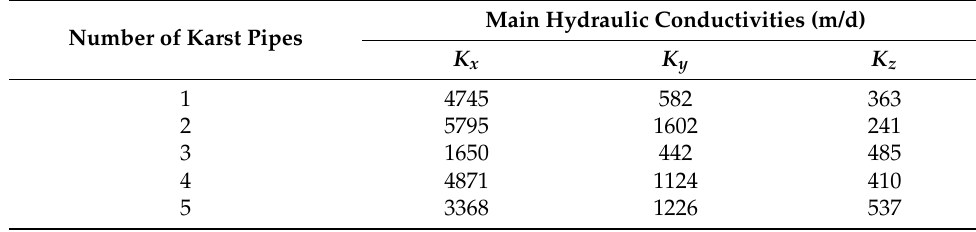
Table 6. Main hydraulic conductivities for karst conduits.